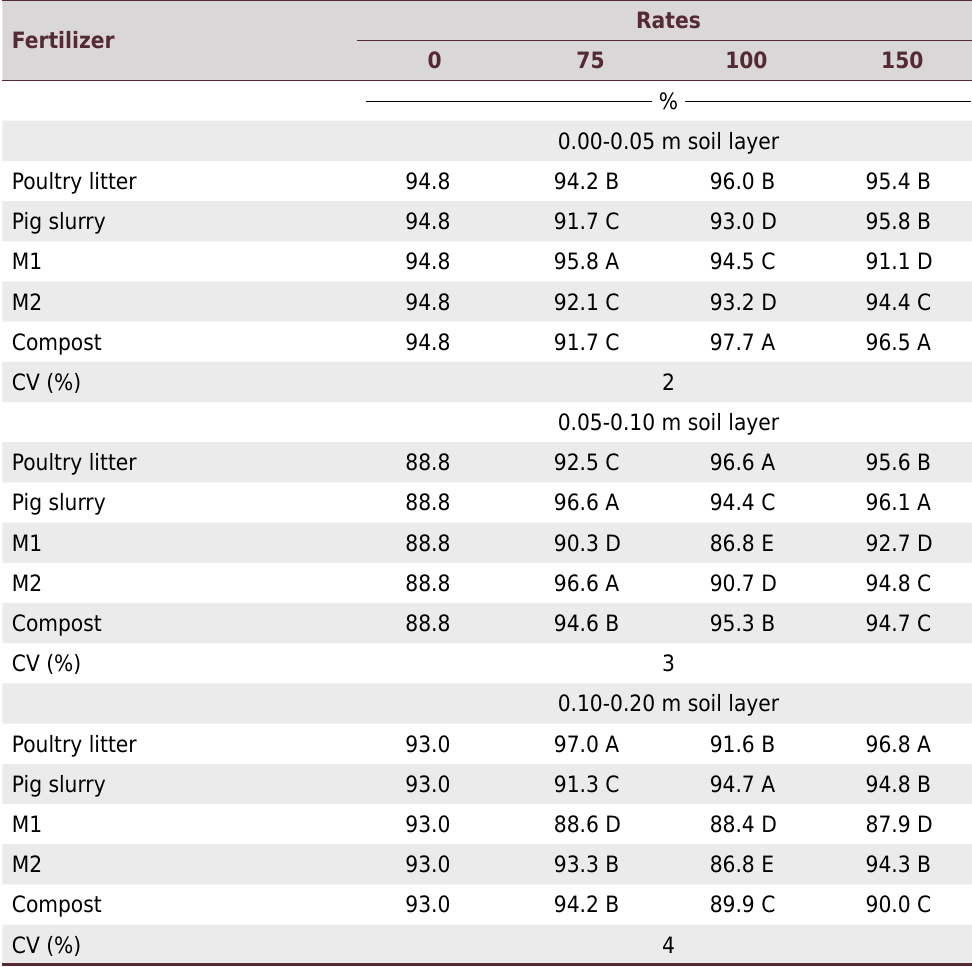
Table 4. Percentage of aggregates of the class (C1 = 8 to 4.76 mm) from a Rhodic Kandiudox, in layers of 0.00-0.05, 0.05-0.10 and 0.10-0.20 m after seven years of the application of different types and rates (%) of organic and mineral fertilizers